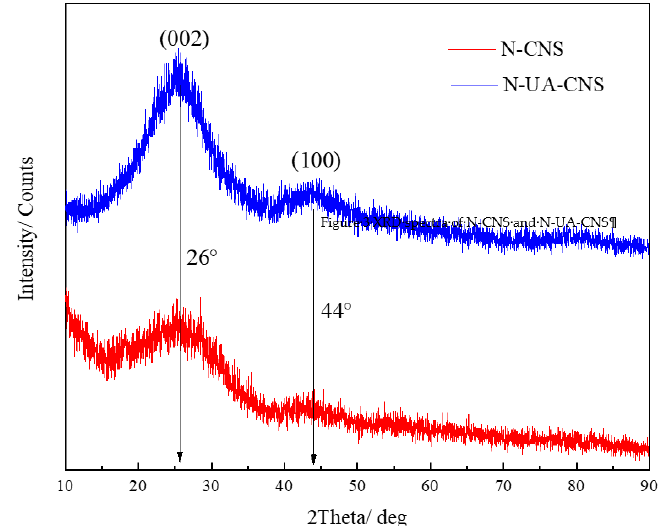
Figure3. XRDspectraoftheself-doped-nitrogenporouscarbonnanosheets(N-CNS)andtheunactivated Figure 3. XRD spectra of the self-doped-nitrogen porous carbon nanosheets(N-CNS) and the self-doped-nitrogen porous carbon unactivated self-doped-nitrogen porous carbon nanosheets(N-UA-CNS).